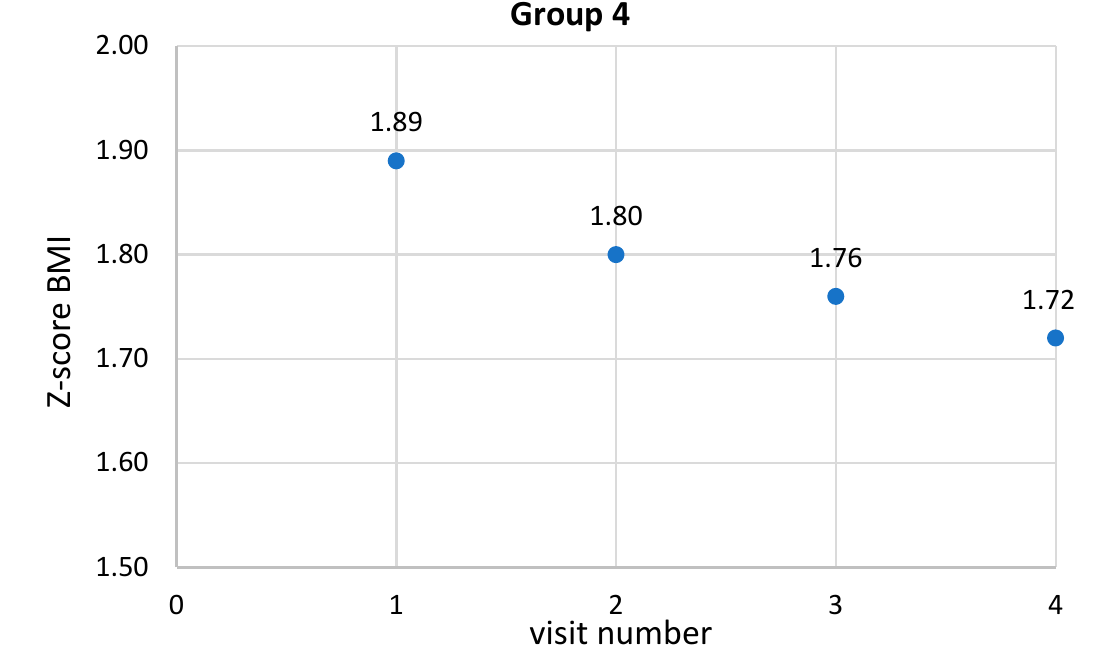
Figure 5. Change in BMI z-score during subsequent intervention